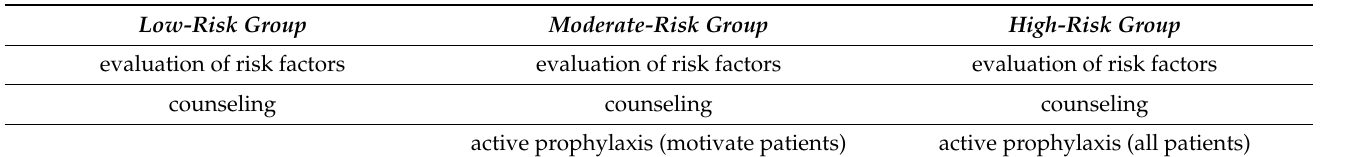
Table 3. The table shows the therapeutic approach to rUTI patients according to the LUTIRE nomo- gram risk factors stratification